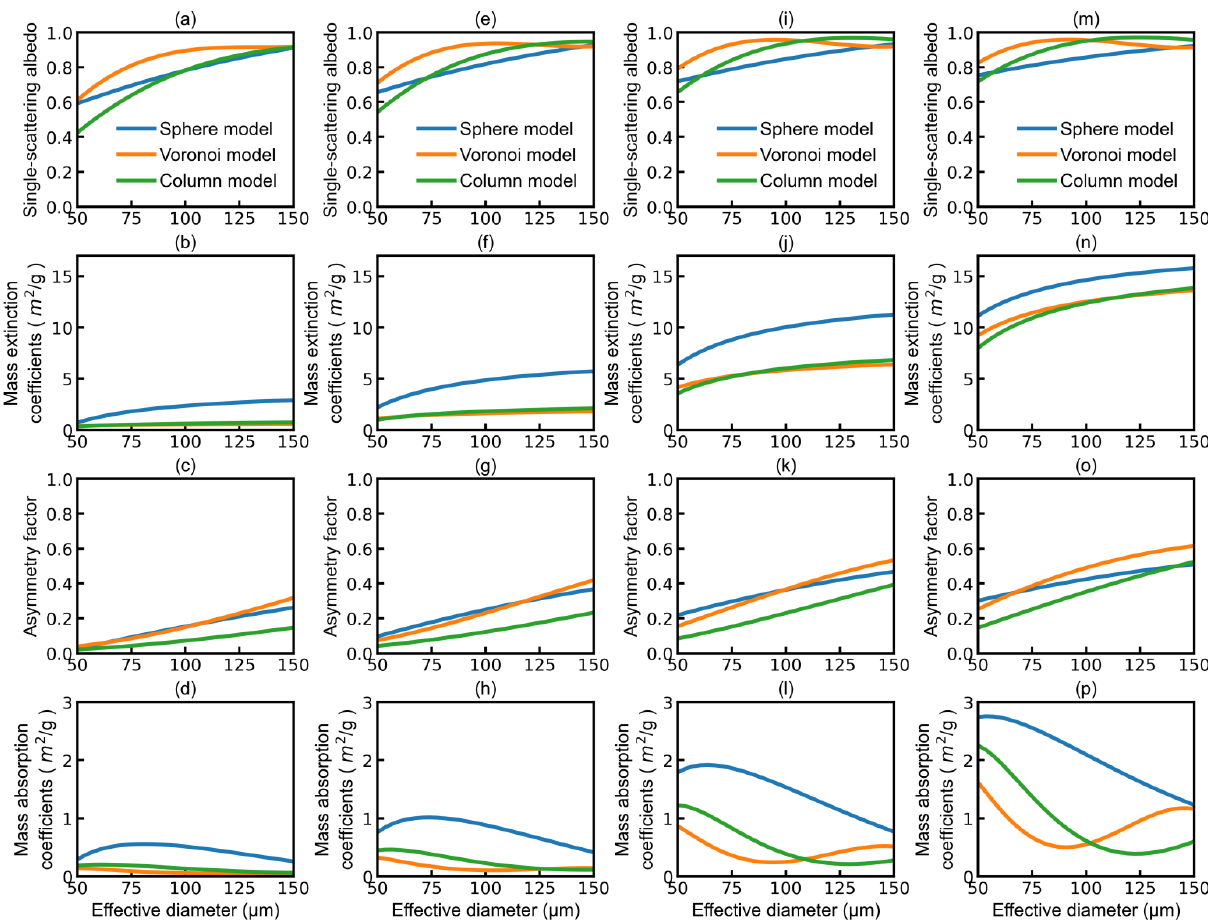
Figure 6. The comparison of the parameterized single-scattering albedo, mass extinction coefficients, asymmetry factor, and mass absorption coefficients as functions of effective diameters for 325, 448, 664, and 874GHz for the sphere (blue line), Voronoi (orange line), and column (green line) ICS